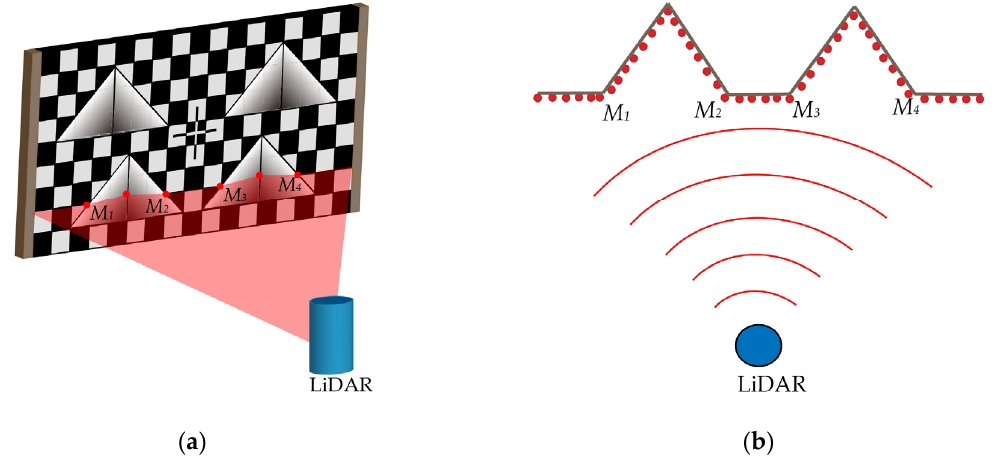
Figure 3. Schematic diagram of LiDAR scanning BWDC. ( a ) The stereo view of LiDAR scanning BWDC. ( b ) The horizontal cross-sectional view of LiDAR scanning BWDC.